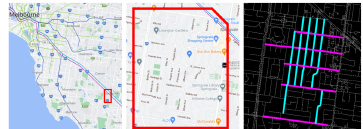
Figure 8. Location map showing the study area to the South-East of metropolitan Melbourne ( left ), the map of the study area next to Springvale Road ( middle ) and the street typology plan showing Type 1 streets (10.5 m wide) coloured cyan, and Type 2 streets (11.5 m wide) coloured magenta ( right